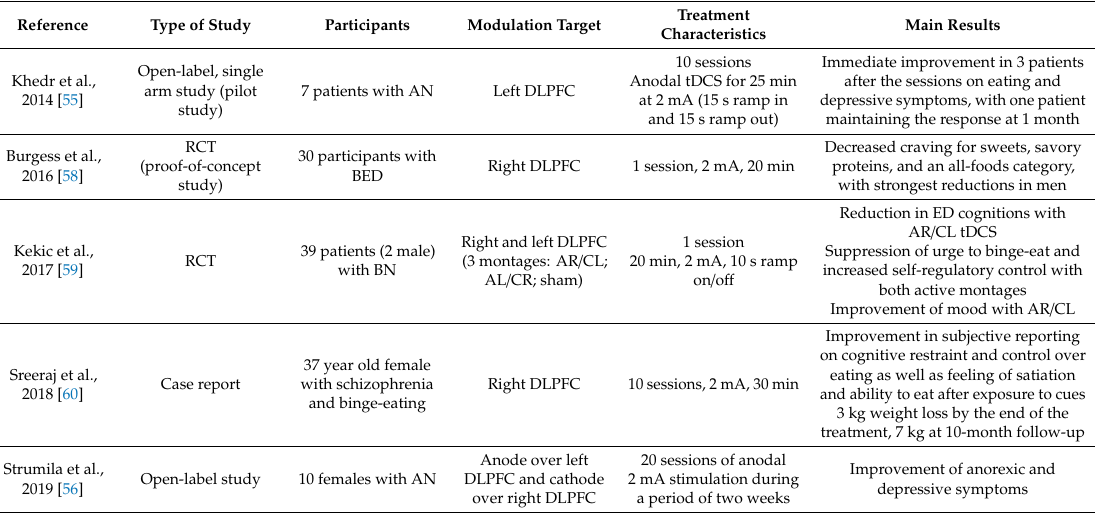
Table 2. Transcranial direct current stimulation (tDCS) and eating